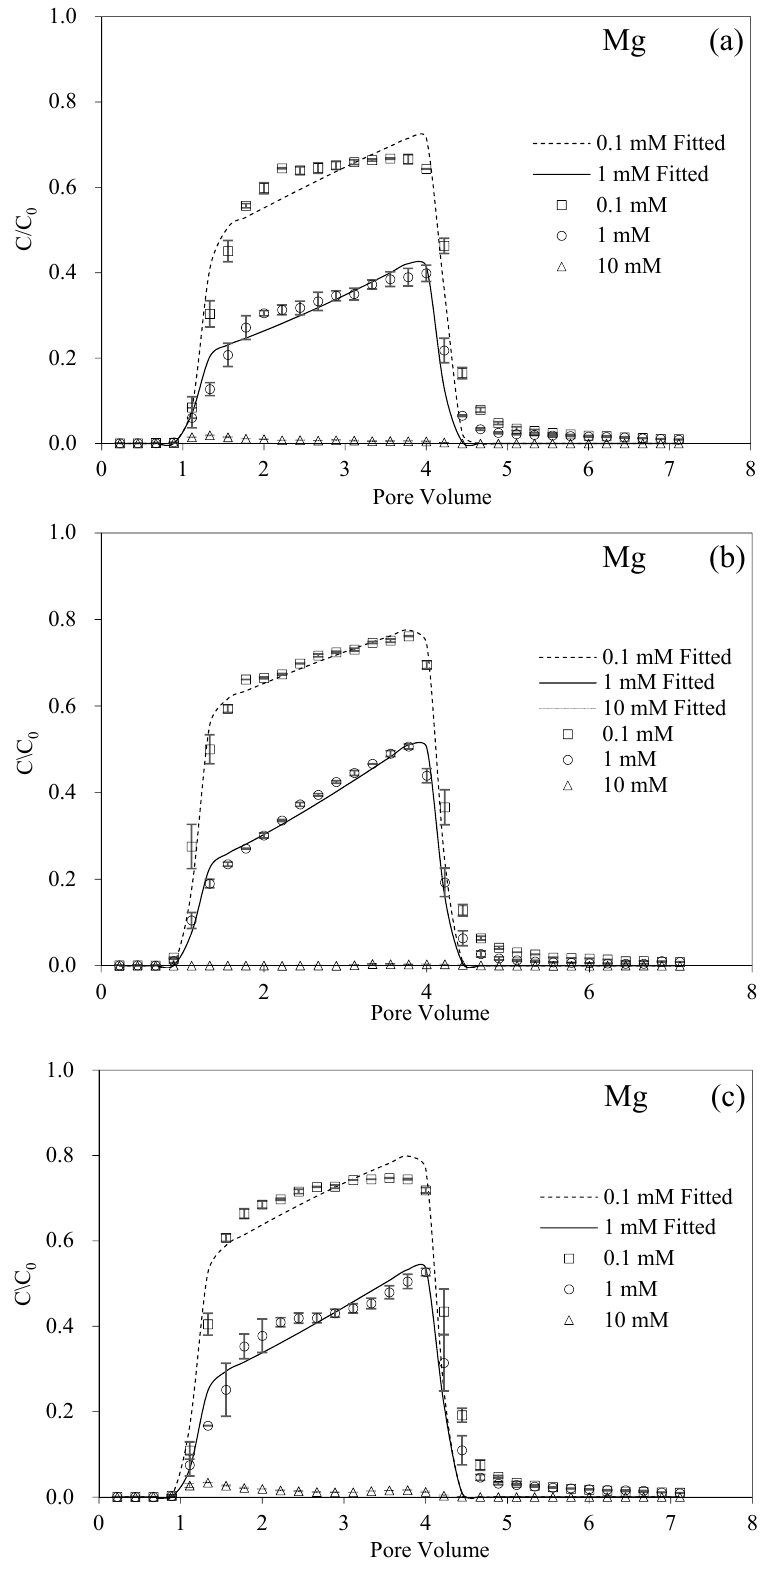
Figure 3. Breakthrough and fitting curves of BMBC at different ISs of Mg with 0 ( a ), 1 ( b ), and 5 ( c ) mg L − 1 HA.